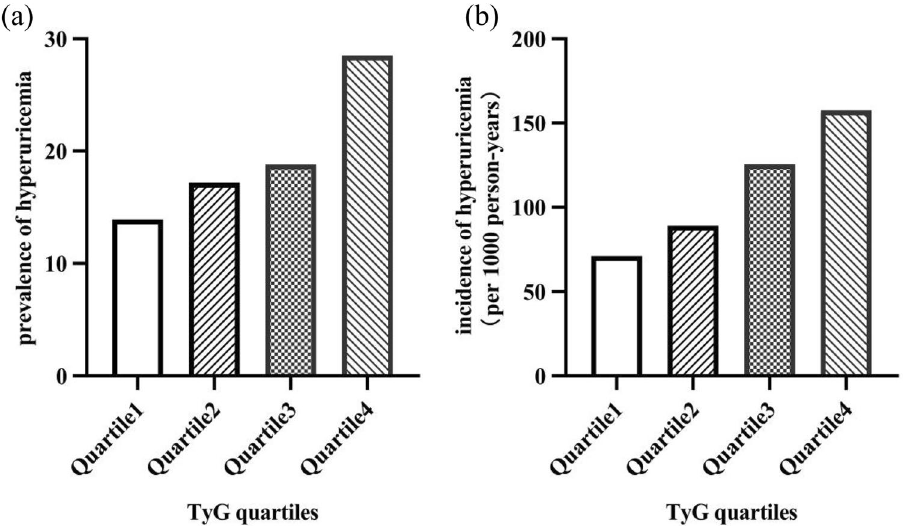
Figure 1. Relationship between baseline TyG and the hyperuricemia ( a ) the prevalence of hyperuricemia in the cross-sectional analysis, by baseline TyG quartile: < 9.02; quartile 2, 9.02–9.45 quartile 3, 9.45–9.96; quartile 4, ≥ 9.96; ( b ) the incidence of hyperuricemia ( per 1,000 person-years) in the cohort analysis, by baseline TyG quartile: quartile 1, < 9.00; quartile 2, 9.00–9.42; quartile 3, 9.42–9.90; quartile 4, ≥ 9.90;